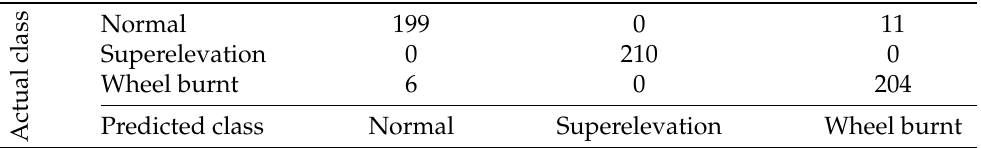
Table 10. Confusion matrix of LSTM 8.5 s split, augmented training dataset and augmented test